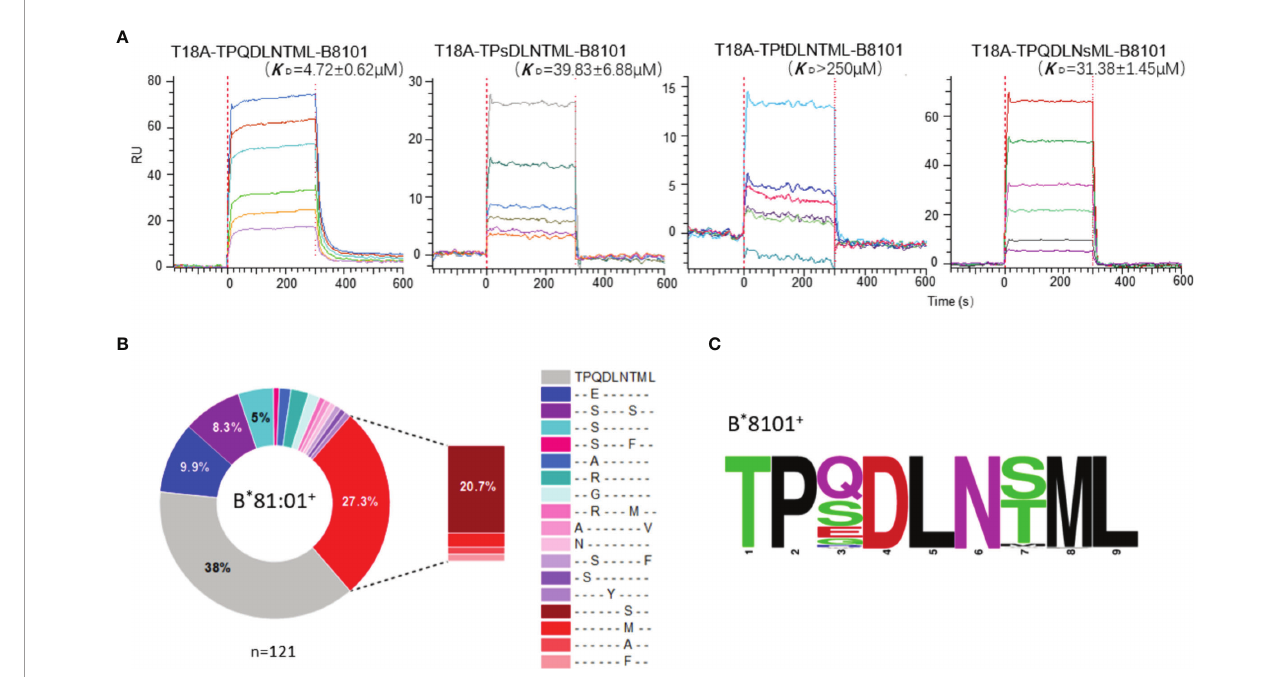
FIGURE 5 | High-af fi nity T18A TCR bind to TL9 or TL9 escape variants under HLA-B*81:01 restriction. (A) SPR binding data for T18A TCR recognition of the wildtype (WT) and popular mutated TL9 presented by HLA-B*81:01. KD values range from 4.7 m M for the WT TL9 peptide to >250 m M for the TPsDLNsML peptide. (B) HLA-associated variation of TL9-Gag in B8101-positve HIV infected patients. (C) Different escape modes in TL9 epitope are illustrated as Sequence Logo, demonstrating TL9 mutation in B8101 background is located at position 3 and